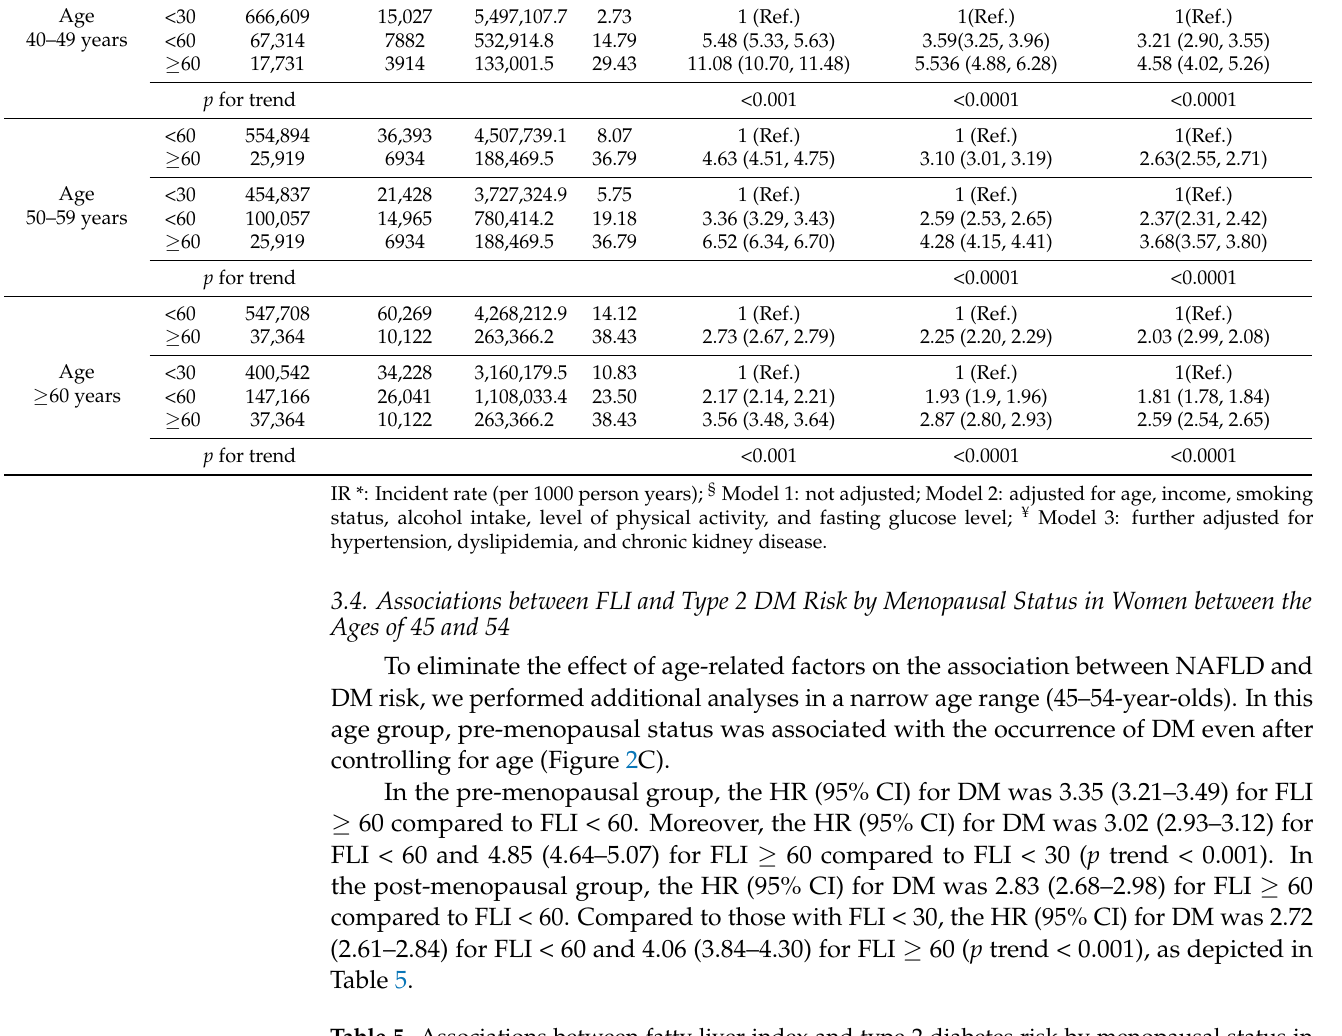
Table 5. Associations between fatty liver index and type 2 diabetes risk by menopausal status in Table 3. Associations between fatty liver index and type 2 diabetes mellitus risk by menopausal